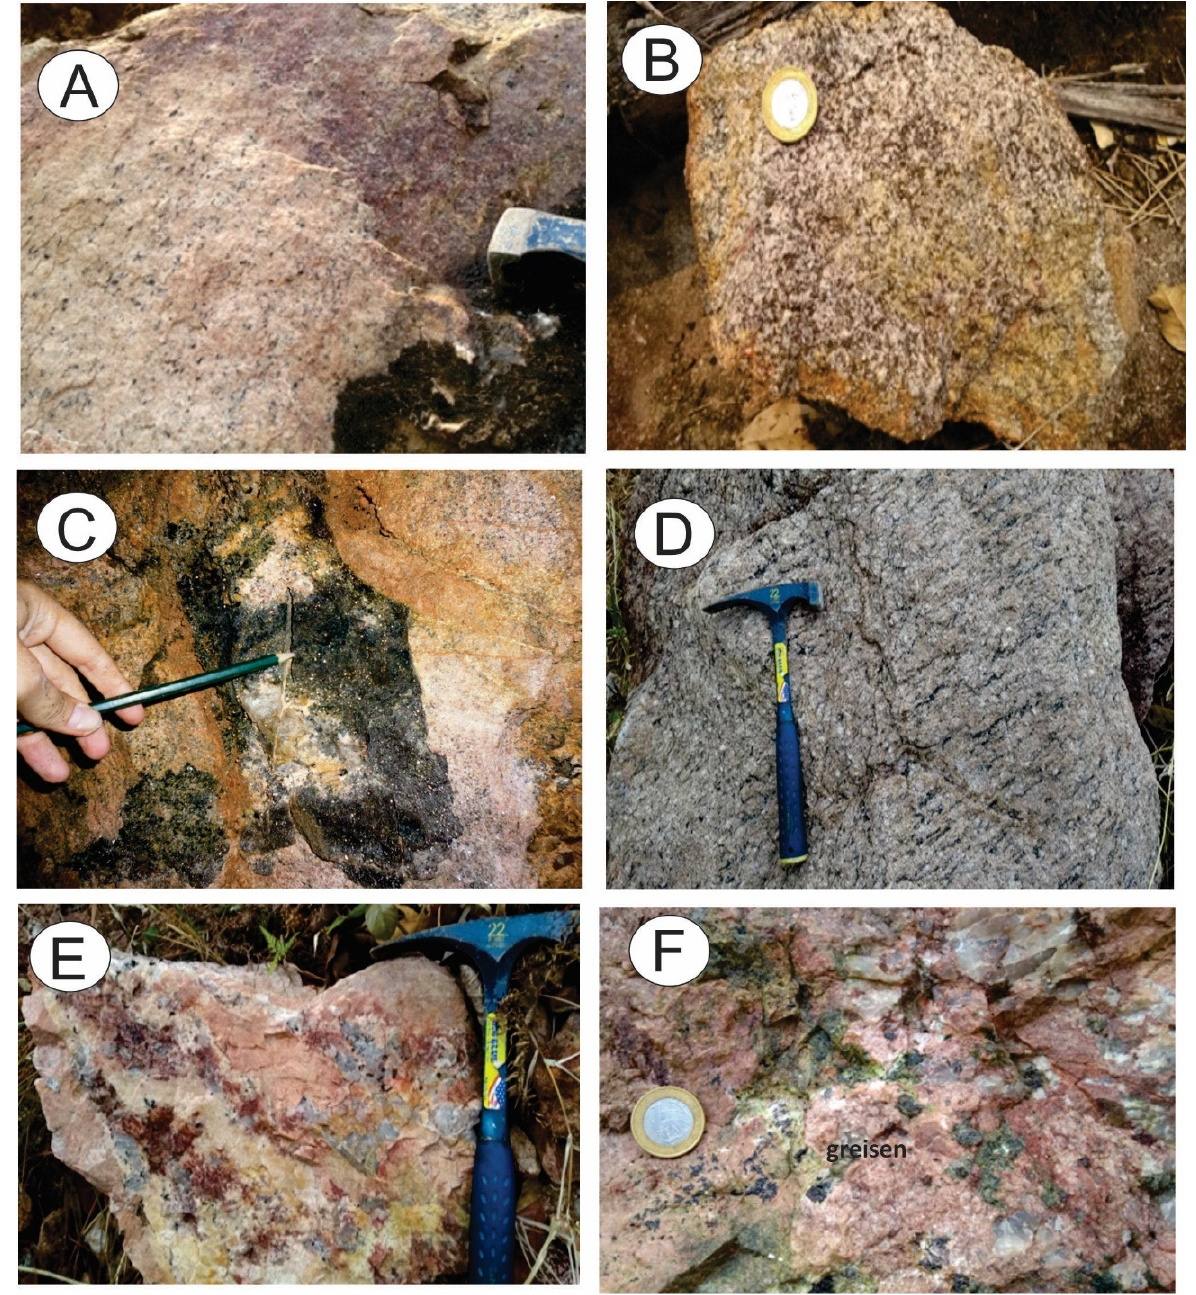
Figure 11. Endogreisen B samples and photographs of samples of the biotite-granite facies related to the endogreisens that make up the São Domingos Region. ( A ) Fine textured biotite with a medium pinkish granite in contact with fine-grained granite gradually changing to zinnwaldite-greisen; ( B ) contact of biotite-granite with topaz-alkali-granite, gradating to coarse or pegmatitic facies; ( C ) fine texture detail of alkali-granite showing sericitized K-feldspar; ( D ) Alkali-granite outcrop showing lenticular quartz veins in ( E ) contact with alkali-granite and alkali-granite topaz; ( F ) Macroscopic appearance of endogreisens associated with topaz-alkali-granite.